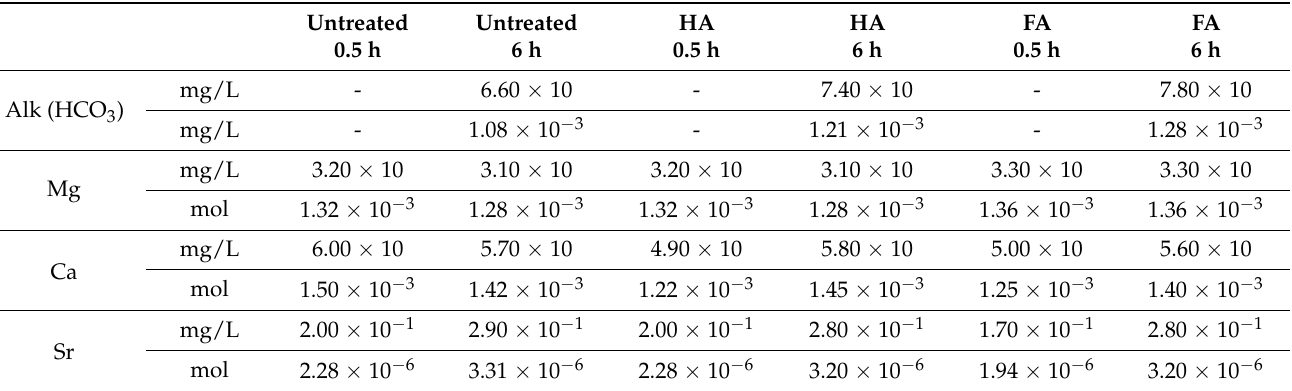
Table 1. Mineral concentrations * over time in experimental solutions of water containing naturally occurring strontium in contact with three pyrolusite media conditions, including untreated, coated with humic acid (HA), and coated with fulvic acid (FA).